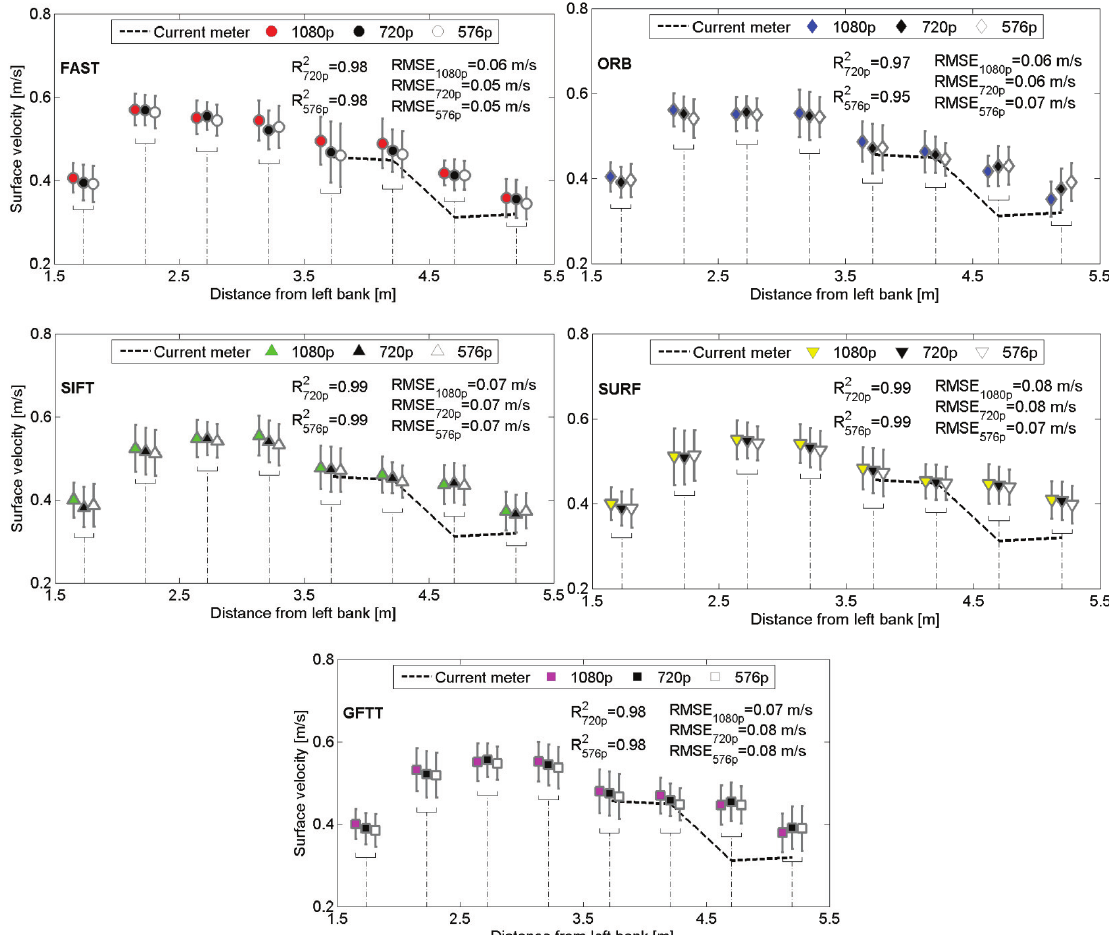
Figure 6. Time-averaged surface flow velocity cross-sectional profiles obtained by processing the 12 image sequences on the Brenta River with OTV. Error bars indicate standard deviations. Black markers pertain to 720 × 953pixels resolutions and white markers to 576 × 763pixels resolutions. The black dashed line illustrates average velocities obtained with the current meter. RMSE values between OTV results and the current meter data are reported. R 2 values computed with respect to the results at 1080 × 1430pixels resolution are showed. OTV data obtained from sequences sampled at different resolutions refer to consistent distances from the left stream bank as indicated with brackets and dash-dotted